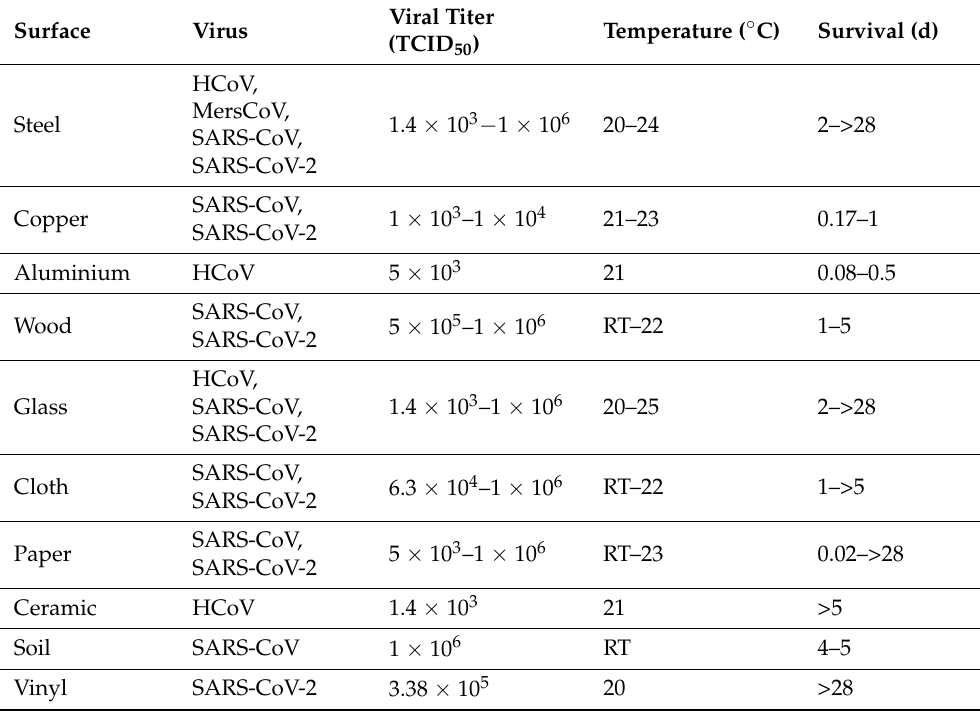
Table 2. Survival of coronaviruses on surfaces near room temperature (adapted from Marzoli et al., 2021)